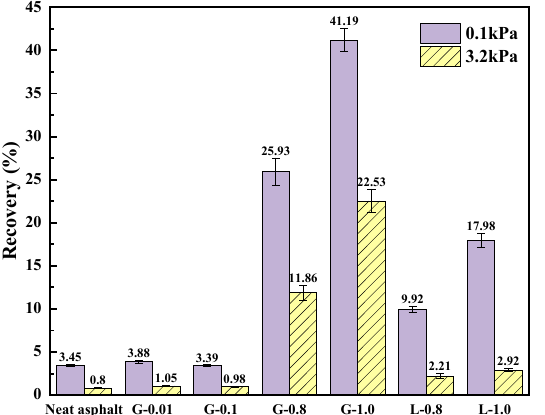
Figure 6. J nr of asphalts and mastics at 60 °C.